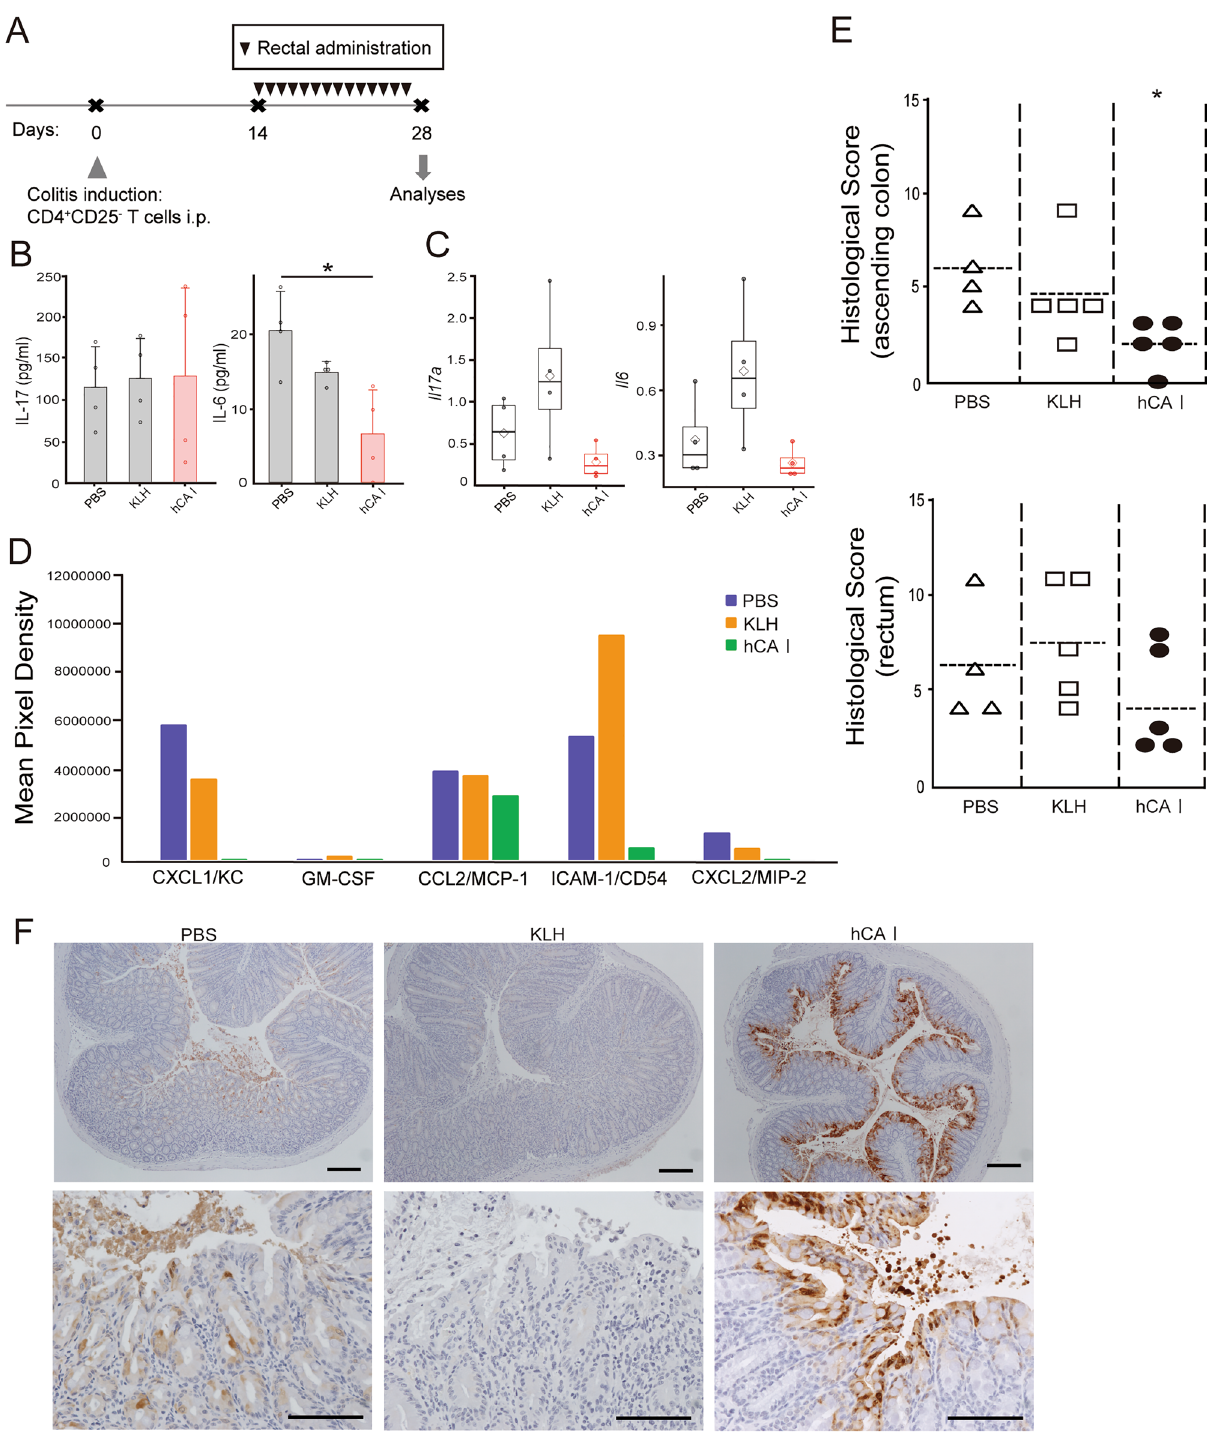
Figure 4. Rectal administration of hCA I after induction of colitis resulted in the suppression of colitis development. ( A ) Experimental protocol (see “Methods”). Four weeks after CD4 + CD25 − T cells were transferred, the MLNs were collected. ( B ) Secreted cytokine concentrations from MLN cells (1 × 10 6 ), cultured with PMA and ionomycin for 72 h, were measured using ELISA; mean ± SD of 4 mice/group. * P < 0.05. ( C ) Transcription factor or cytokine mRNA expression levels in MLN cells were measured using real-time RT-PCR; white diamond indicates the mean, horizontal lines indicate the median, line indicate ± SD of 4 mice/group. * P < 0.05. ( D ) Secreted cytokine concentrations from colons were measured using Mouse Cytokine Array; the supernatants (n = 3) collected from each group were mixed. ( E ) Histological scores on day 28. Horizontal bars: median; * P < 0.05 (vs. PBS-treated mice). Left; ascending colon, Right; rectum. CD4 + CD25 − T cell (3 × 10 5 ) transfer model mice (n = 4–5 mice/group) were treated with PBS, KLH, and hCA I indicated as triangles, squares, and black circles, respectively. One mouse in the PBS group died due to the procedure during intraperitoneal administration of CD4 + CD25 − T cells. ( F ) CA I expression was evaluated using immunohistochemical staining. Representative images at high (original scale, 200 μm) and low (original scale, 100 μm) magnifications are shown. Data shown are from single